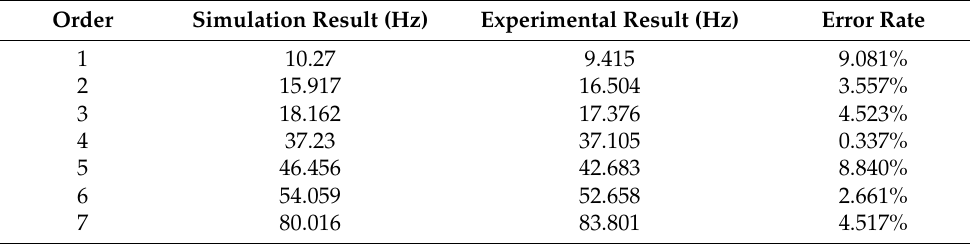
Taking the vibration mode diagram of the first four modes in Table 1 as an example, the modal vibration mode diagrams for the simulation analyses and tests are shown in Figure 3, Figure 4, Figure 5 and Figure 6, respectively.